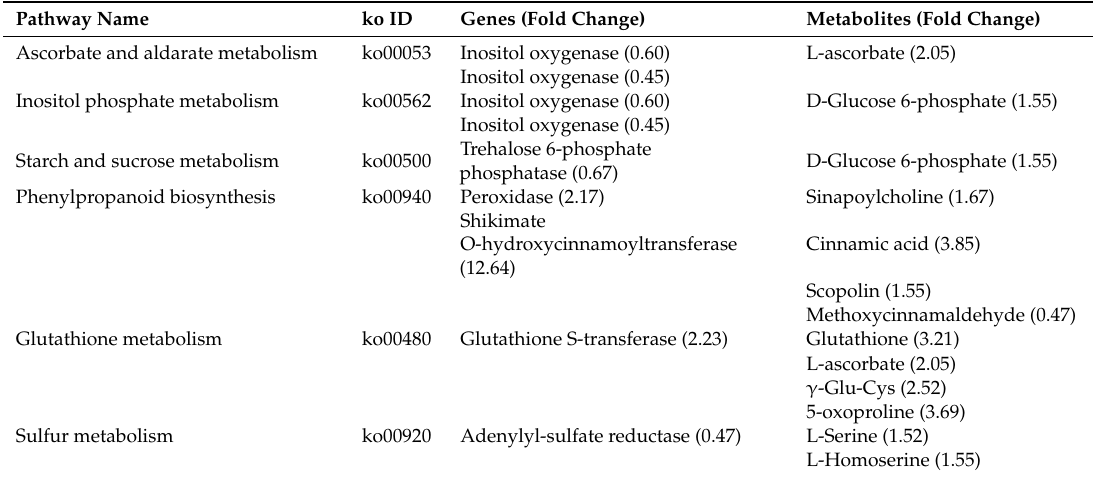
Table 3. DEGs and SCMs involved in other metabolic